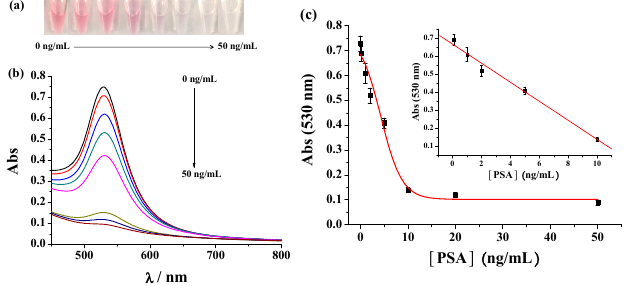
Figure 4. The photographic images ( a ) and UV-Vis absorption spectra ( b ) for assays of different concentrations of PSA (0, 0.1, 1, 2, 5, 10, 20 and 50 ng/mL).